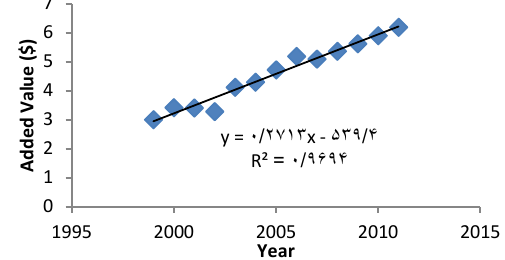
Figure 4. Variations of added value in the food and beverage industries over a period of 13 years.